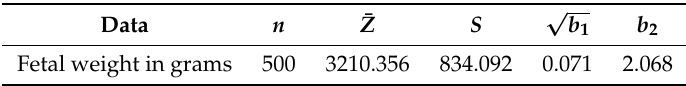
Table 8. Summary statistics for variable fetal weight in grams.